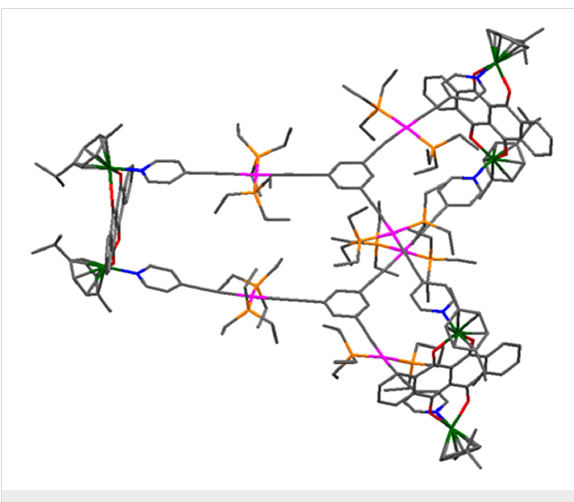
Figure 4: Energy-minimized structure of heterometallic trigonal pris- matic cage 3a . Hydrogen atoms are omitted for the sake of clarity [Ru: green, Pt: pink, O: red, N: blue, P: orange, C: